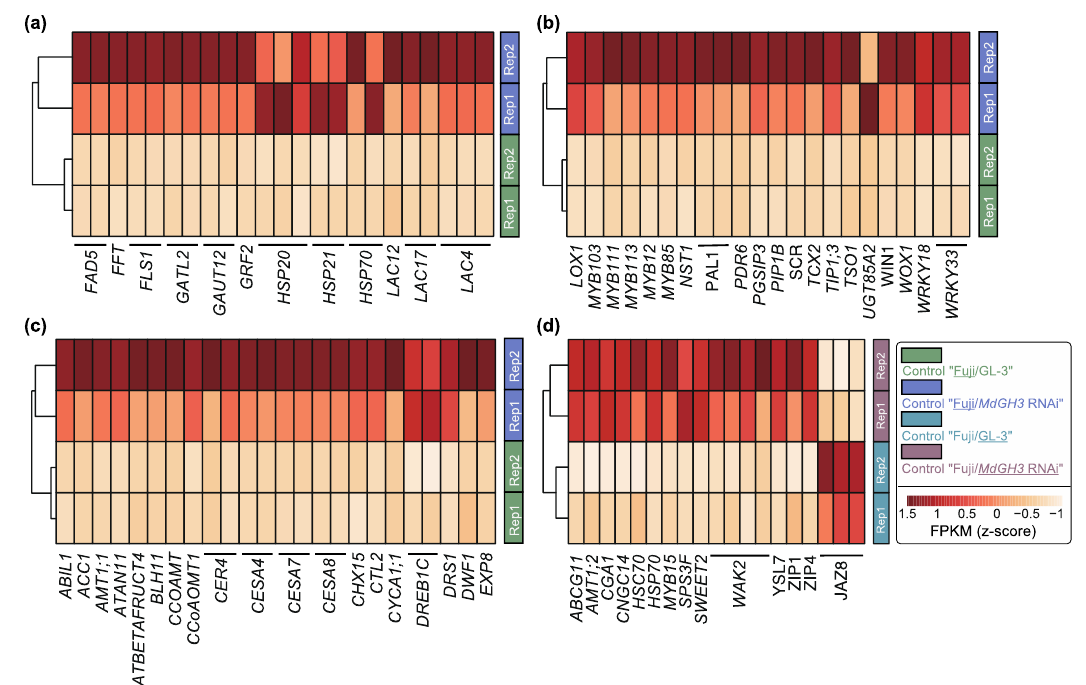
Figure 3. Heatmap plots show the differentially expressed genes (DEGs) associated with stress and growth in scion and rootstock obtained by comparing “Fuji/ MdGH3 RNAi” plants with “Fuji/GL-3” plants under control conditions. ( a – c ) DEGs in scion obtained by comparing “Fuji/ MdGH3 RNAi” to “Fuji/GL-3” under control conditions. ( d ) DEGs in rootstock obtained by comparing “Fuji/ MdGH3 RNAi” to “Fuji/GL-3” under control conditions.